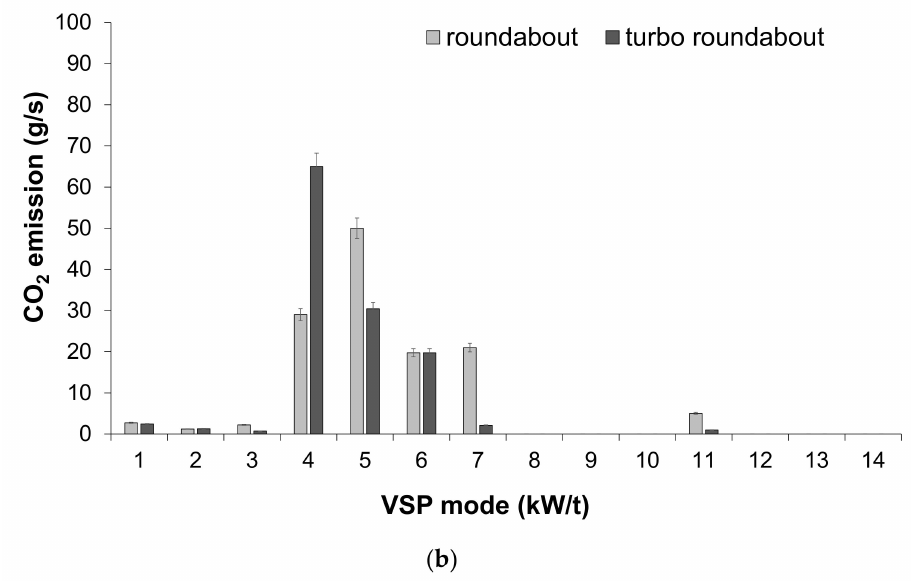
Figure 10. Turbo roundabout versus roundabout: ( a ) speed-time profiles; ( b ) simulated CO 2 emis- sions for through